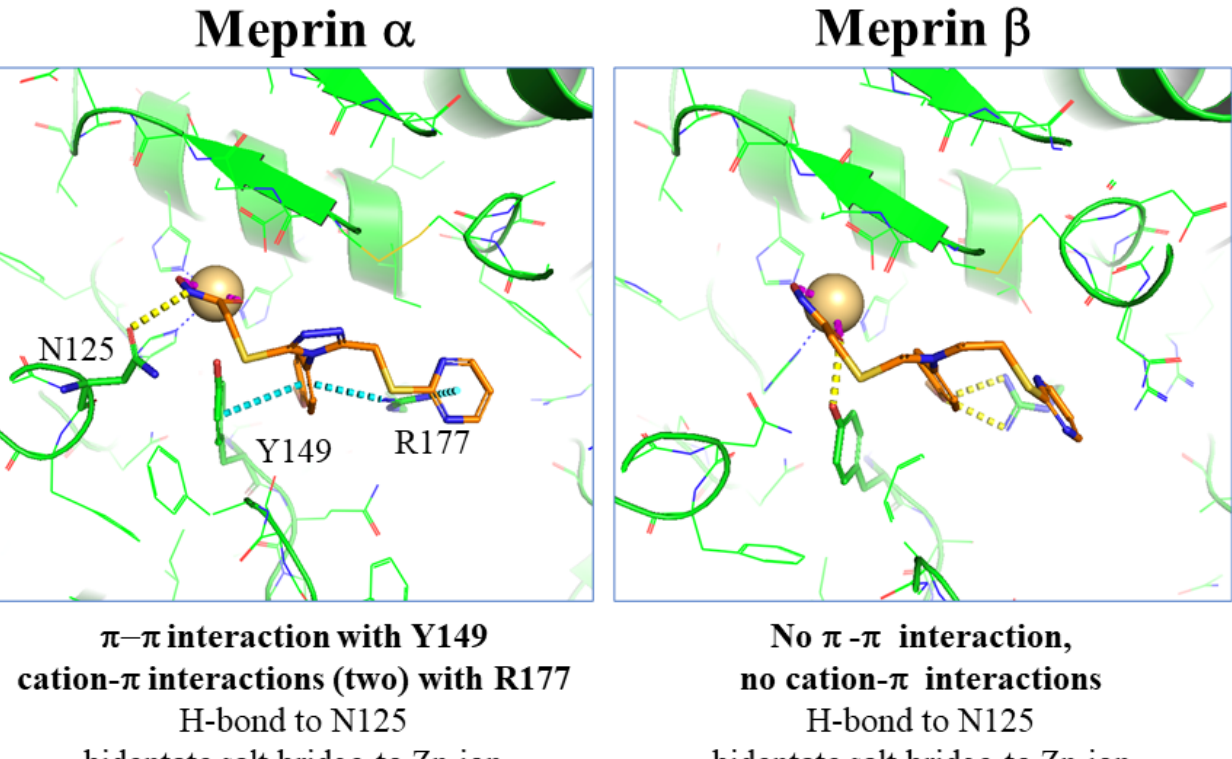
Figure 2. SR19855 docked to meprins α and β .